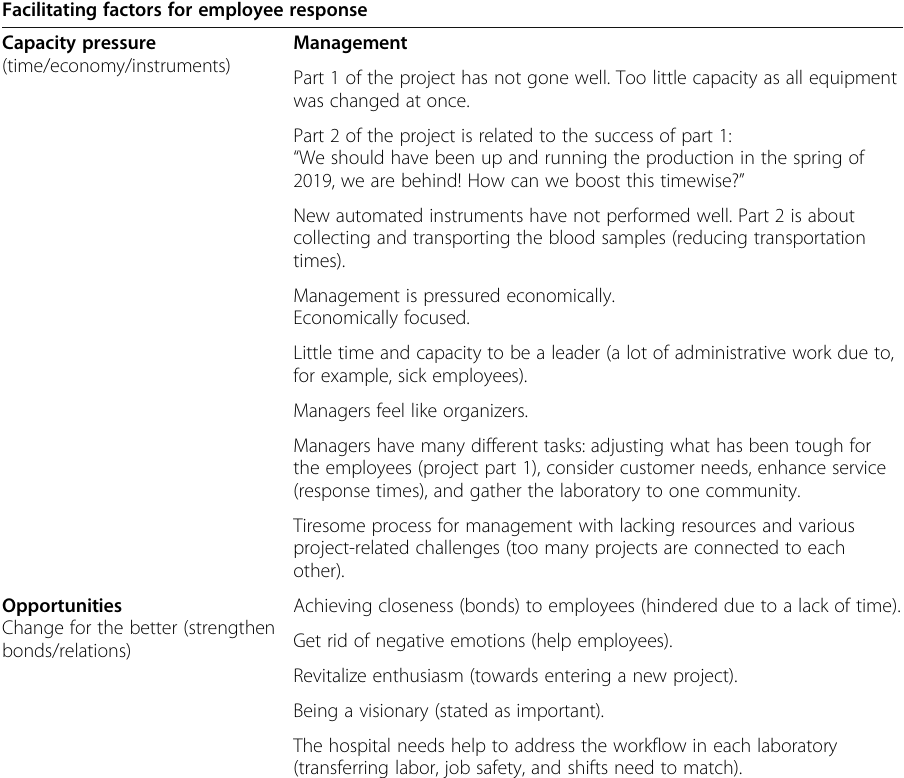
Facilitating factors for employee response Capacity pressure